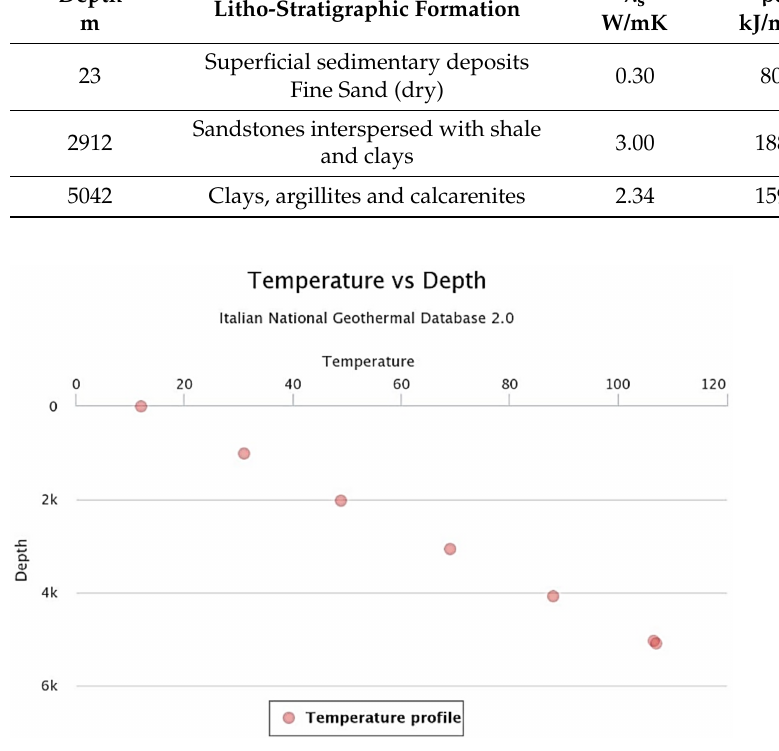
Figure 3. Temperature data visualisation for the Tempa Rossa 1D hydrocarbon well: Depth (m); Temperature ( ◦